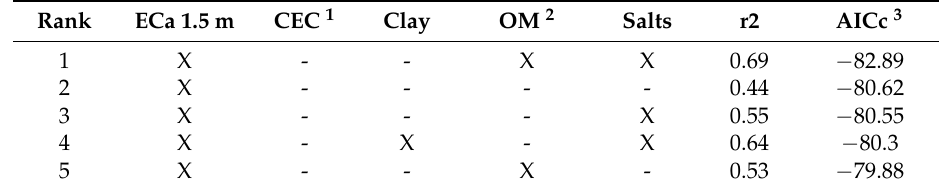
Table 2. Automated model selection output for the first five models by rank. Full model consisted in the kriged apparent electrical conductivity (values of 1.5 m depth combined with soil properties to explain soil water content. Selected variables for each best model are indicated with an